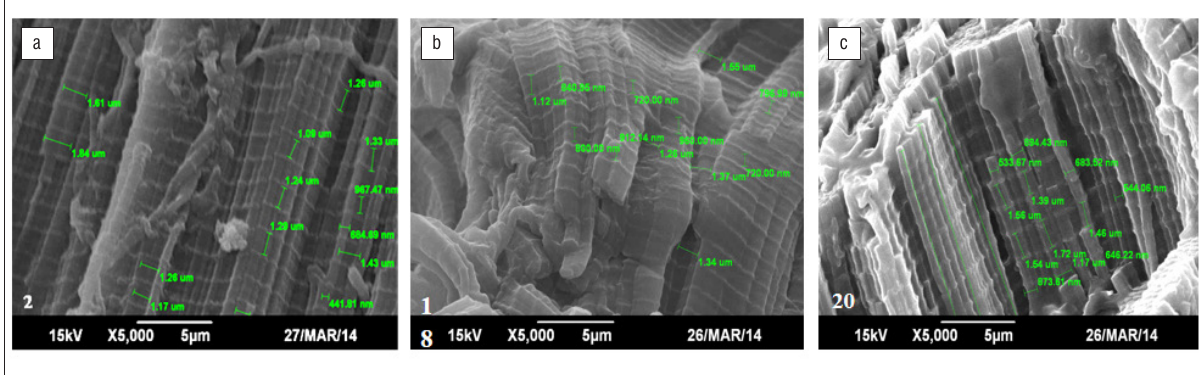
Figure 2: Length and width between intercalated discs of the Muscularis longissimus thoracis et lumborum muscle of cows from (a) non-descript, (b) Nguni and (c) Bonsmara breeds of